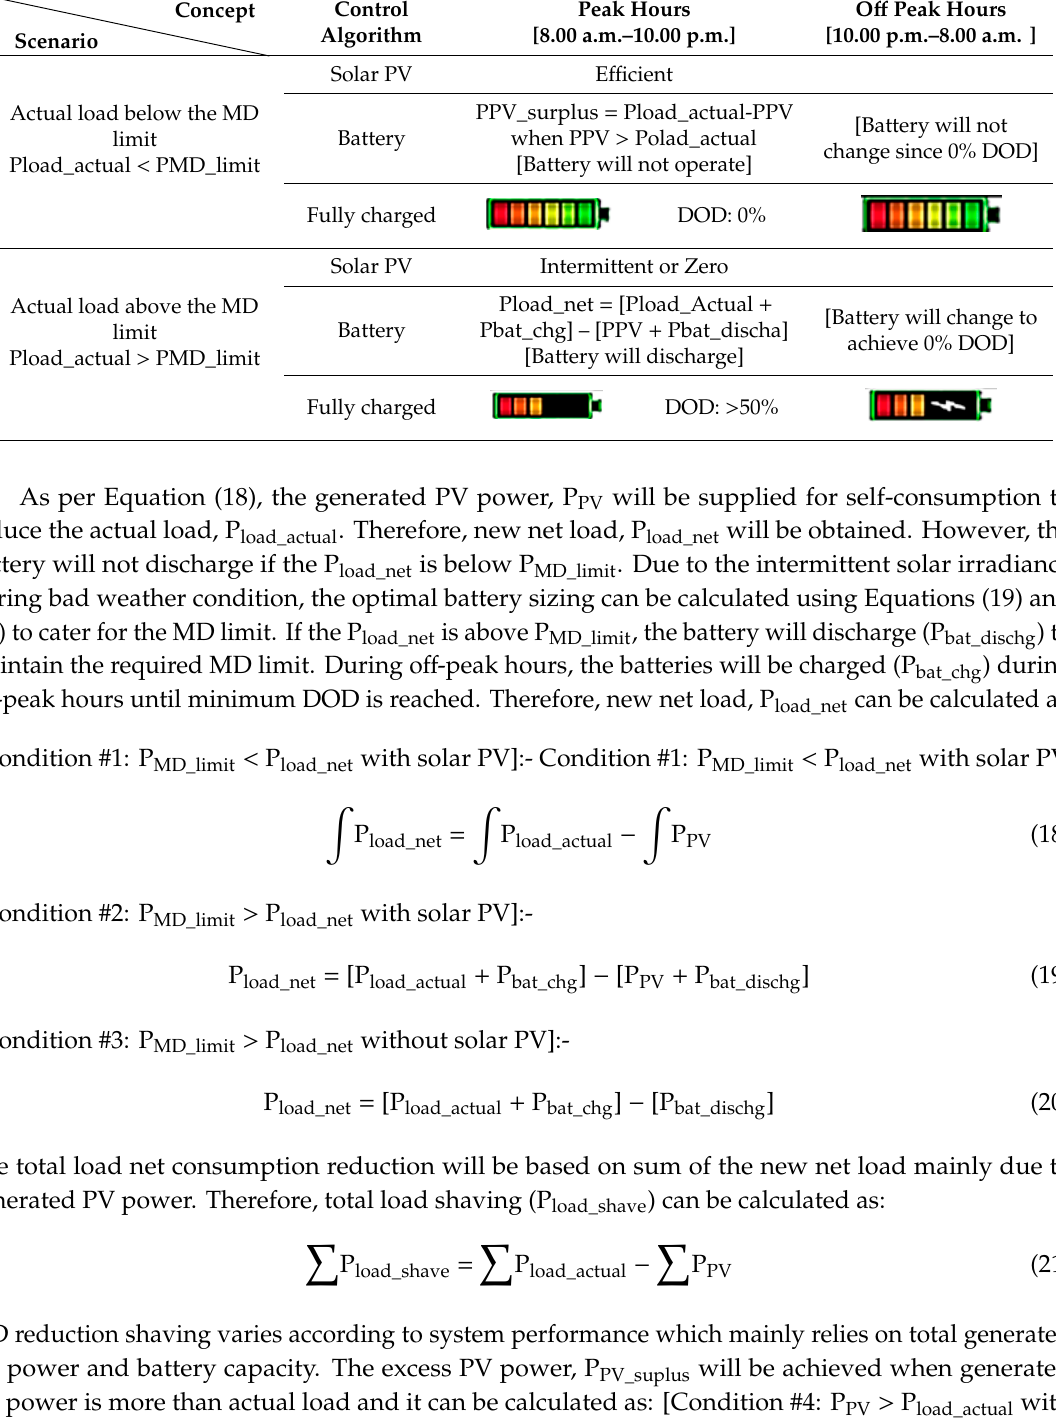
Figure 5. Flowchart of MDRed model for optimal sizing simulation using Genetic Algorithm. Table 7. Battery Energy management system for MDRed modeling approach.